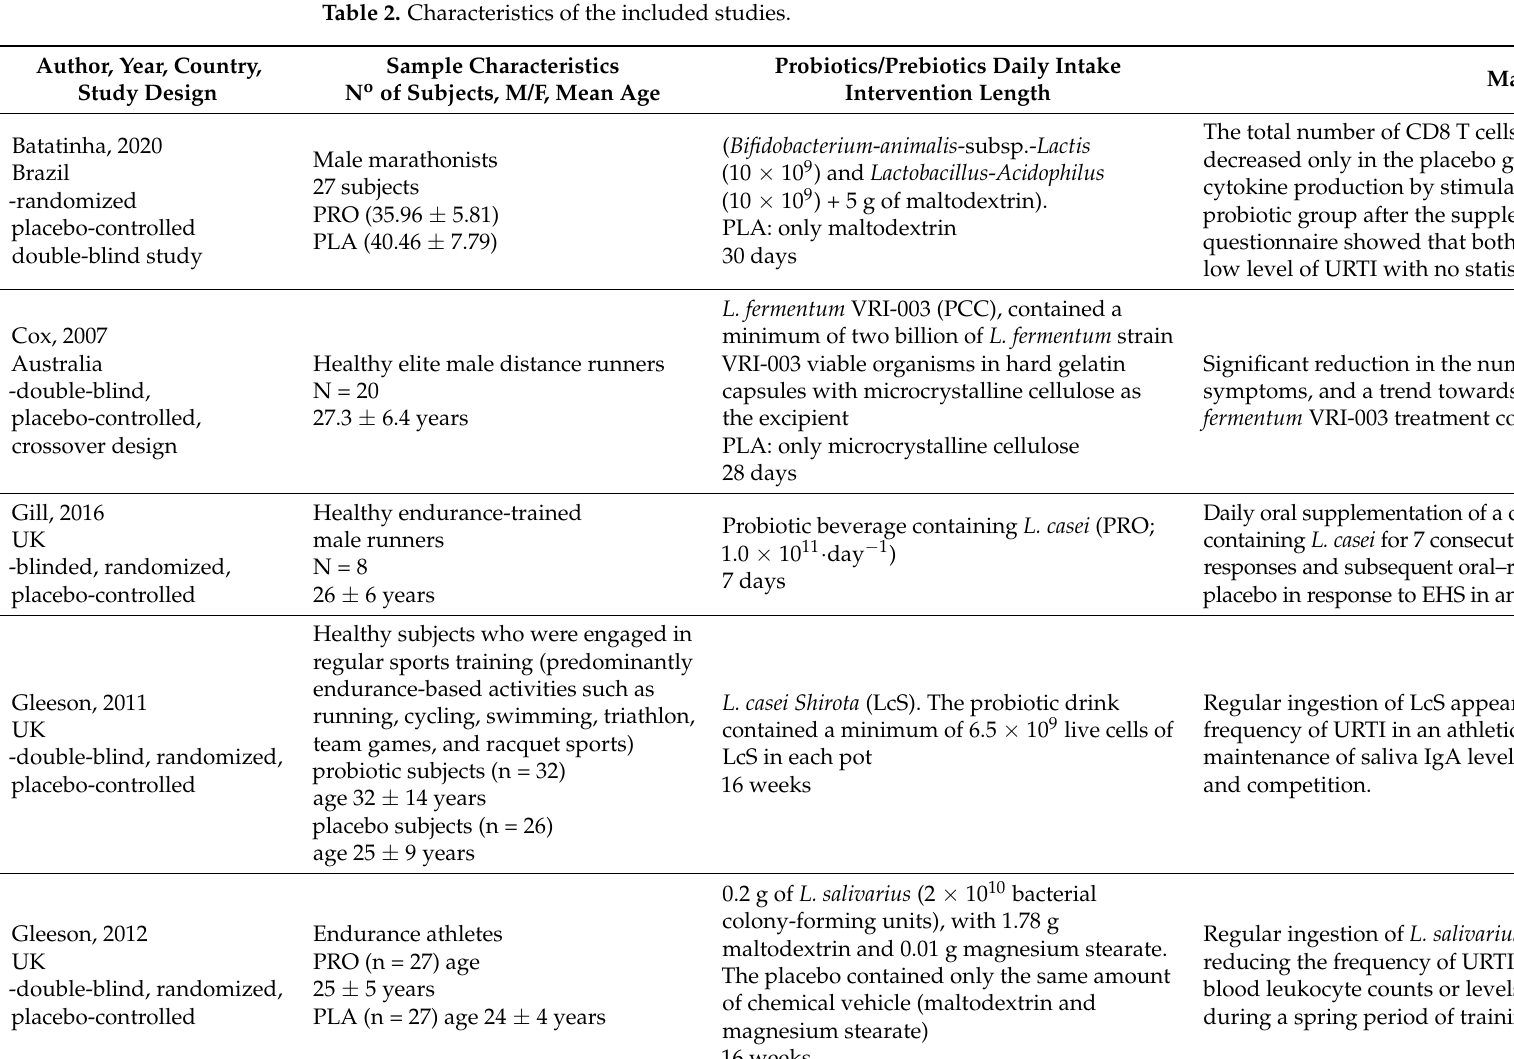
Table 2. Characteristics of the included